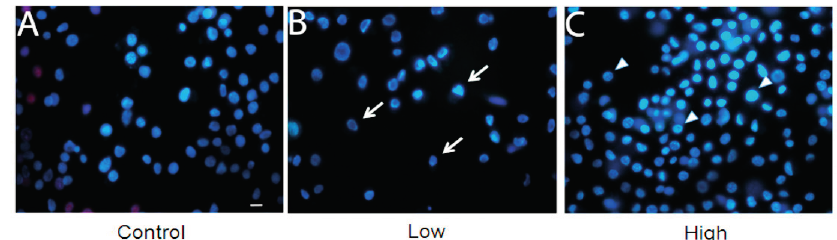
Low: cell maintained without glucose addition ( B ); and High: cells maintained with 100 mM of glucose ( C ). The arrows indicate the shape of low-glucose cells and the triangles indicate the rounded shape of high-glucose cells. Scale bar: 10 μ